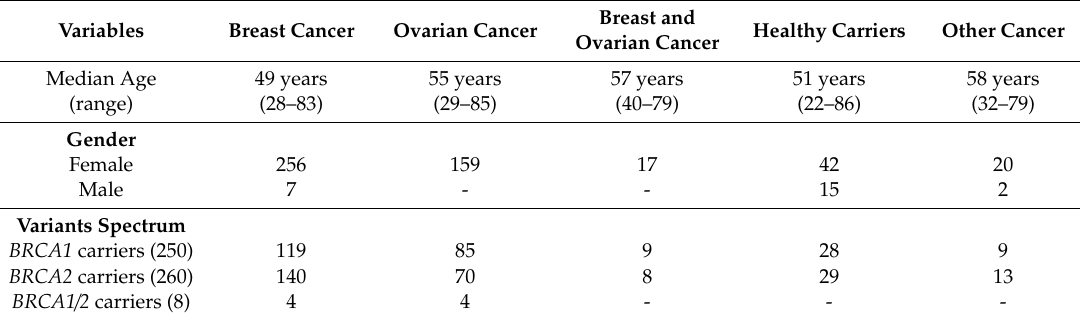
Table 1. Prevalence of BRCA1 / 2 variants in the 517 out of 2351 individuals